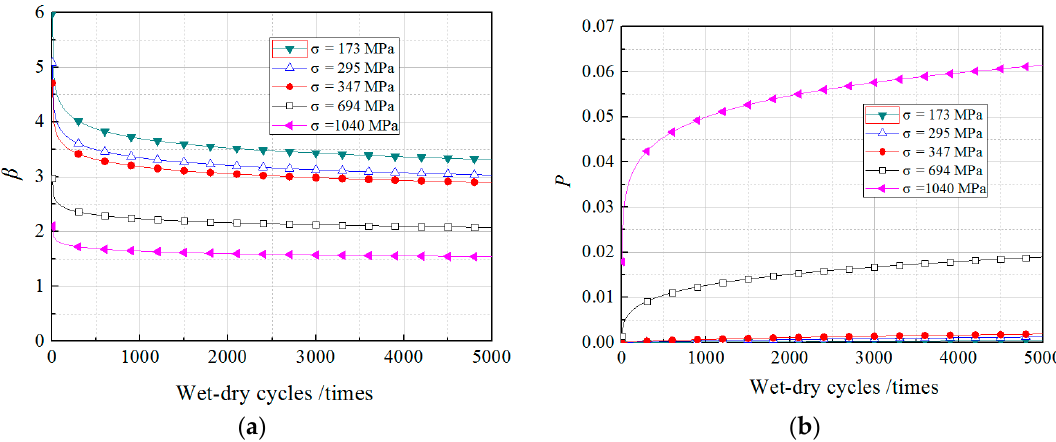
Figure 9. The effects of standard deviations of the load on the CFRP specimens: ( a ) Change of β with wet-dry cycles; and ( b ) change of P with wet-dry cycles.